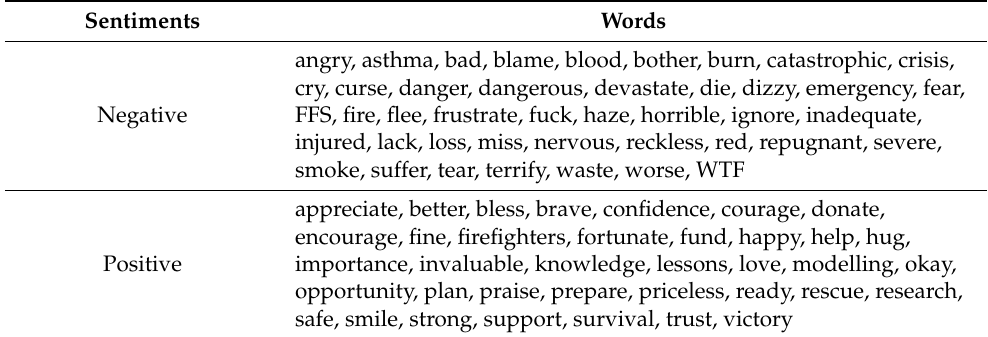
Table 2. A sample of word bags for sentiment analysis.